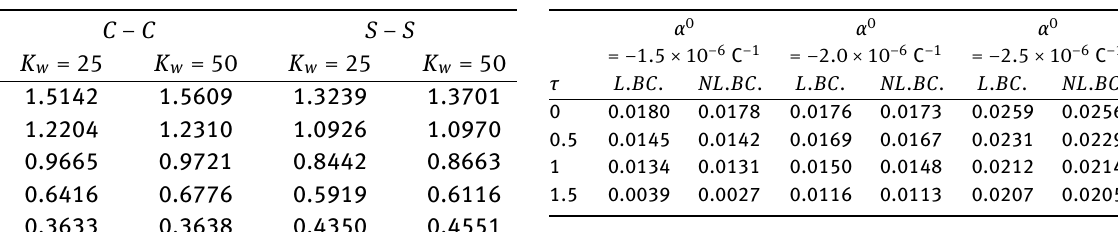
Table 2: Nonlocal constant and Winkler foundation effects on fre-